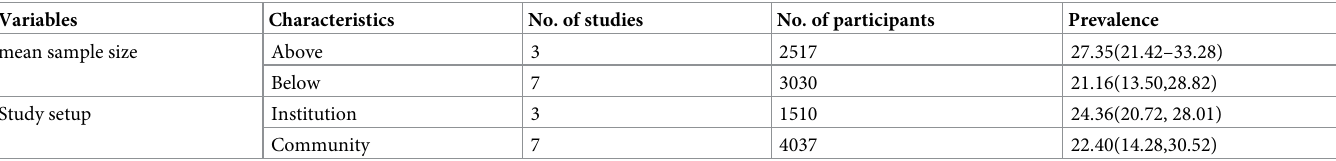
Table 3. Subgroup prevalence of adolescent girls anemia in Ethiopian, 2020 (n =